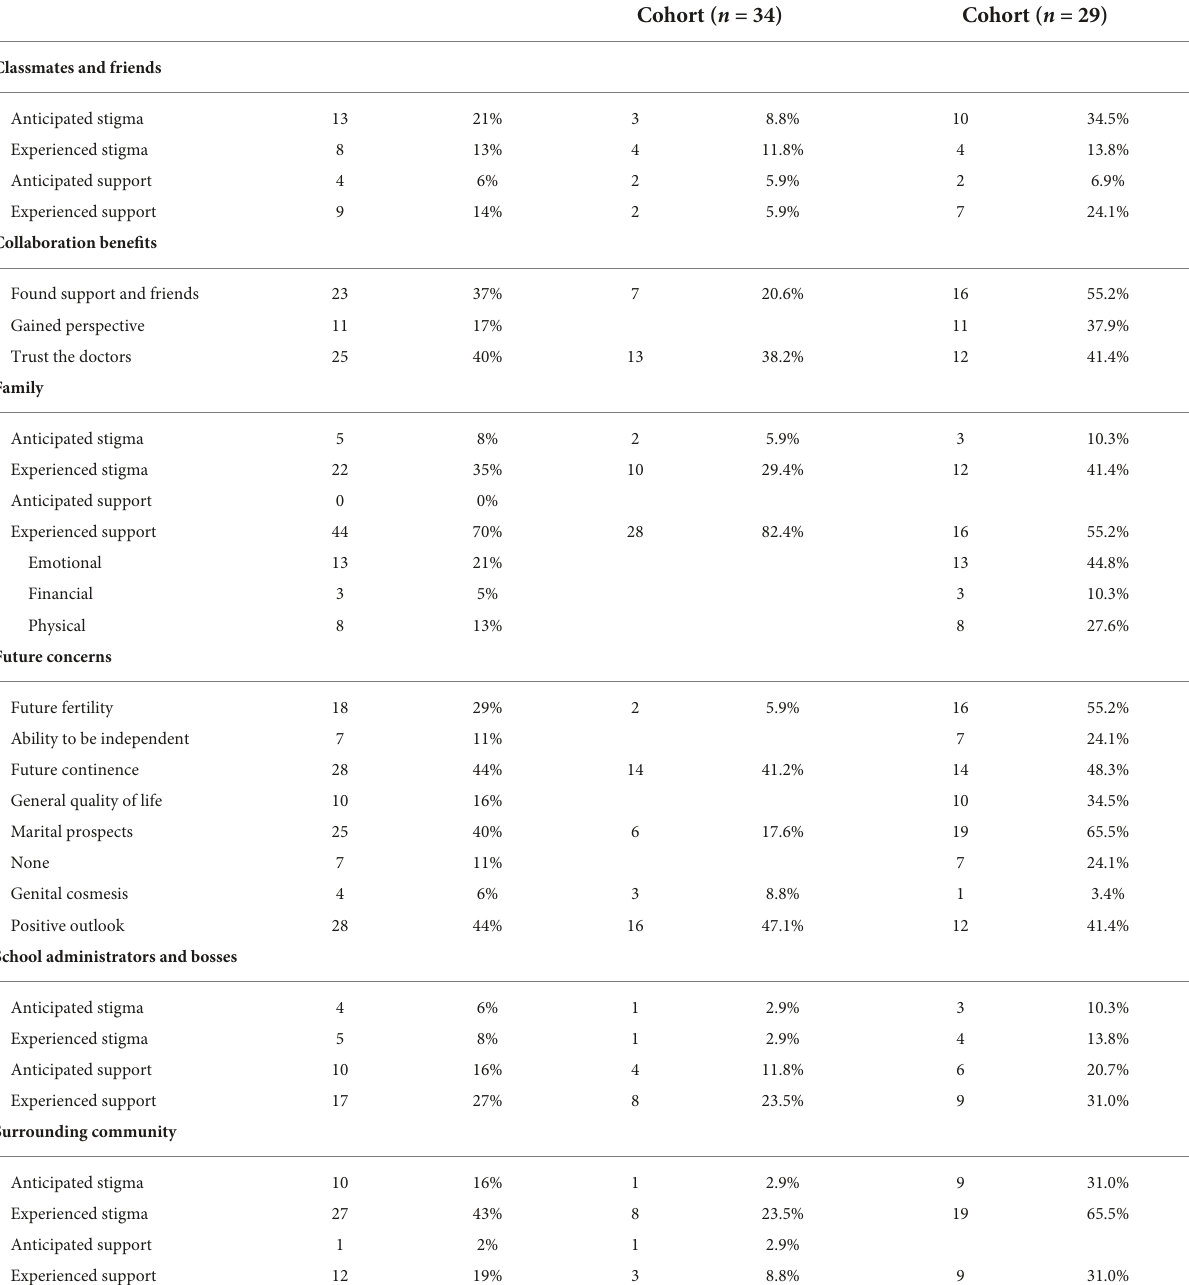
TABLE 1 Qualitative interview